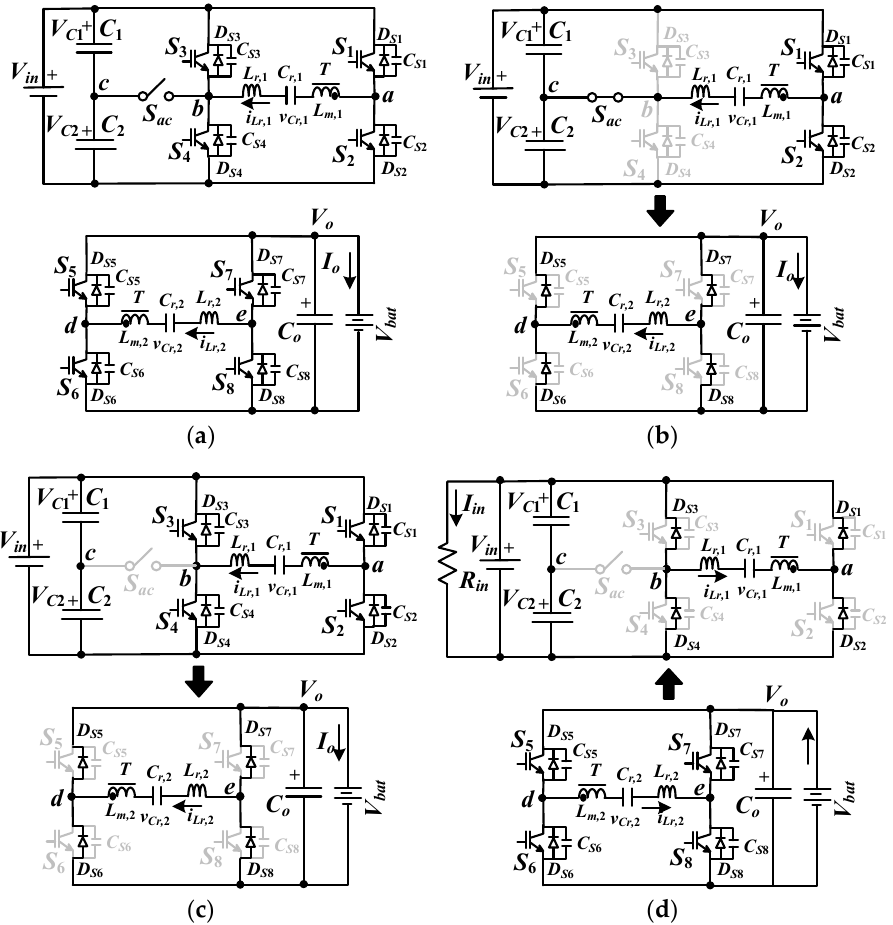
Figure 3. Proposed resonant converter with bidirectional power flow and wide output voltage operation: ( a ) circuit structure; ( b ) forward power flow and low output voltage range; ( c ) forward power flow and high-output voltage range; ( d ) backward power operation.